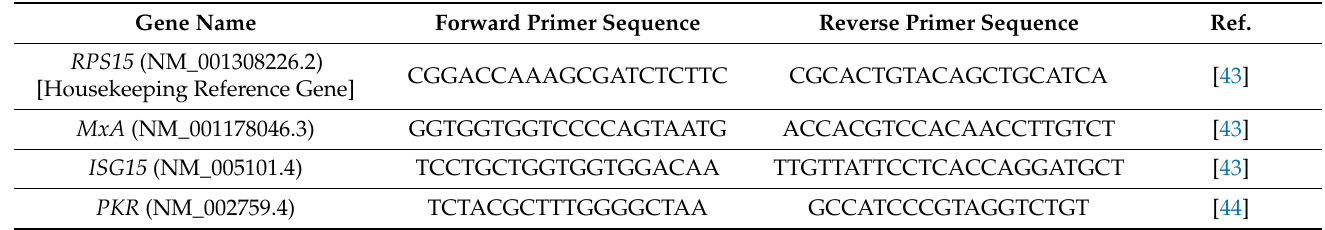
Table 1. qRT-PCR primers